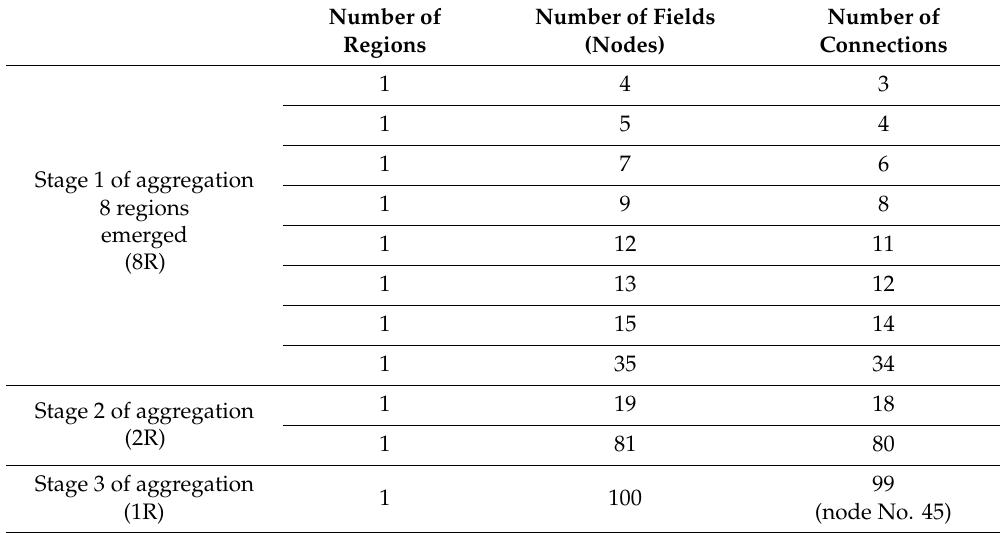
Table 7. Characteristics of the structure of networks formed according to the maximum value increase